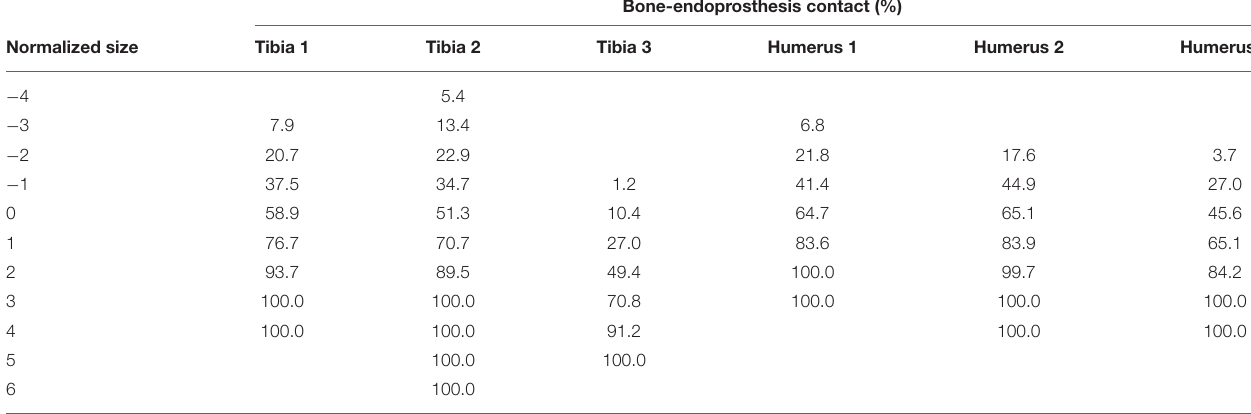
Bone-endoprosthesis contact (%)